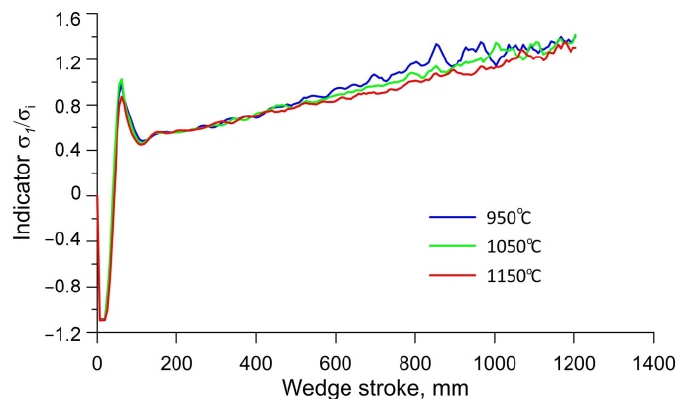
Figure 8. Variation in the stress-state indicator σ 1 / σ i at point P0 at different rolling temperatures.